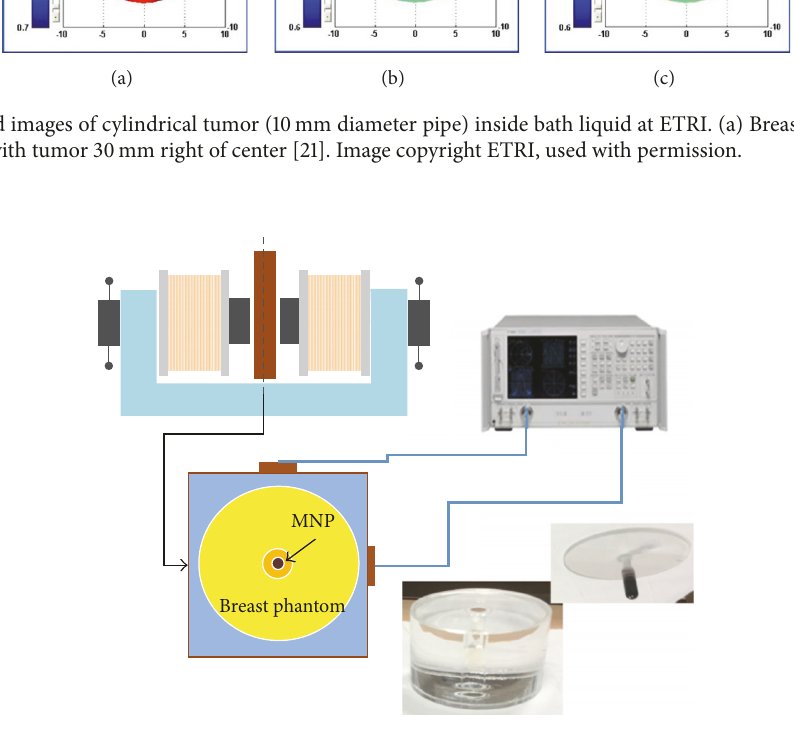
Figure 15: Experimental setup of IREA, National Research Council of Italy for MNP enhanced microwave imaging [22]. Image copyright IEEE, used with